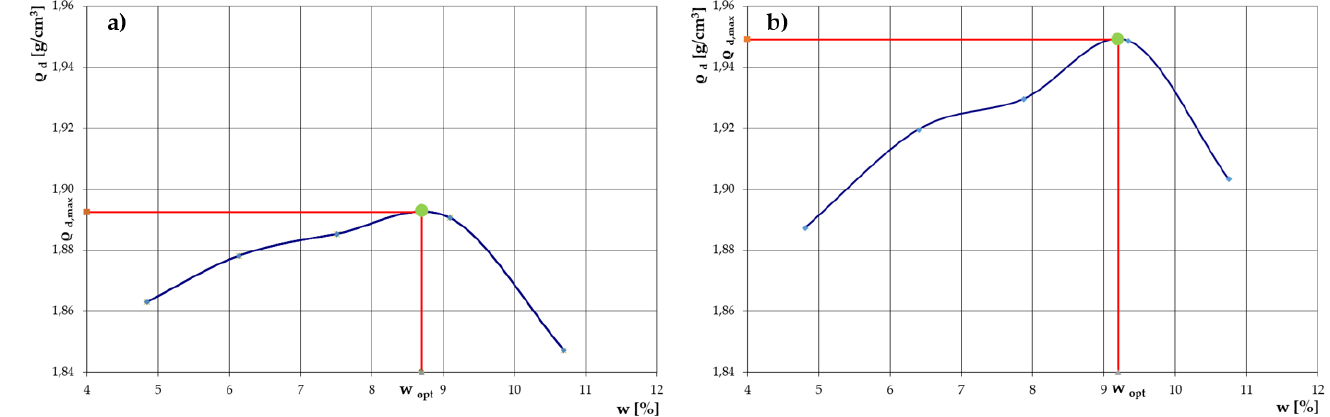
Figure 4. Comparison of optimum moisture content w opt for samples: ( a ) f Si+Cl, 1 = 15.14% and (b) f Si+Cl, 2 = 20.48% (the blue line is the volumetric density curve of the soil in relation to its moisture content, the red line is the horizontal drop from the Y axis of the maximum volumetric density value of the soil and the vertical drop to the X axis (moisture content) to determine the optimum moisture con- tent, the green color indicates the point of inflection of the curve of the graph).